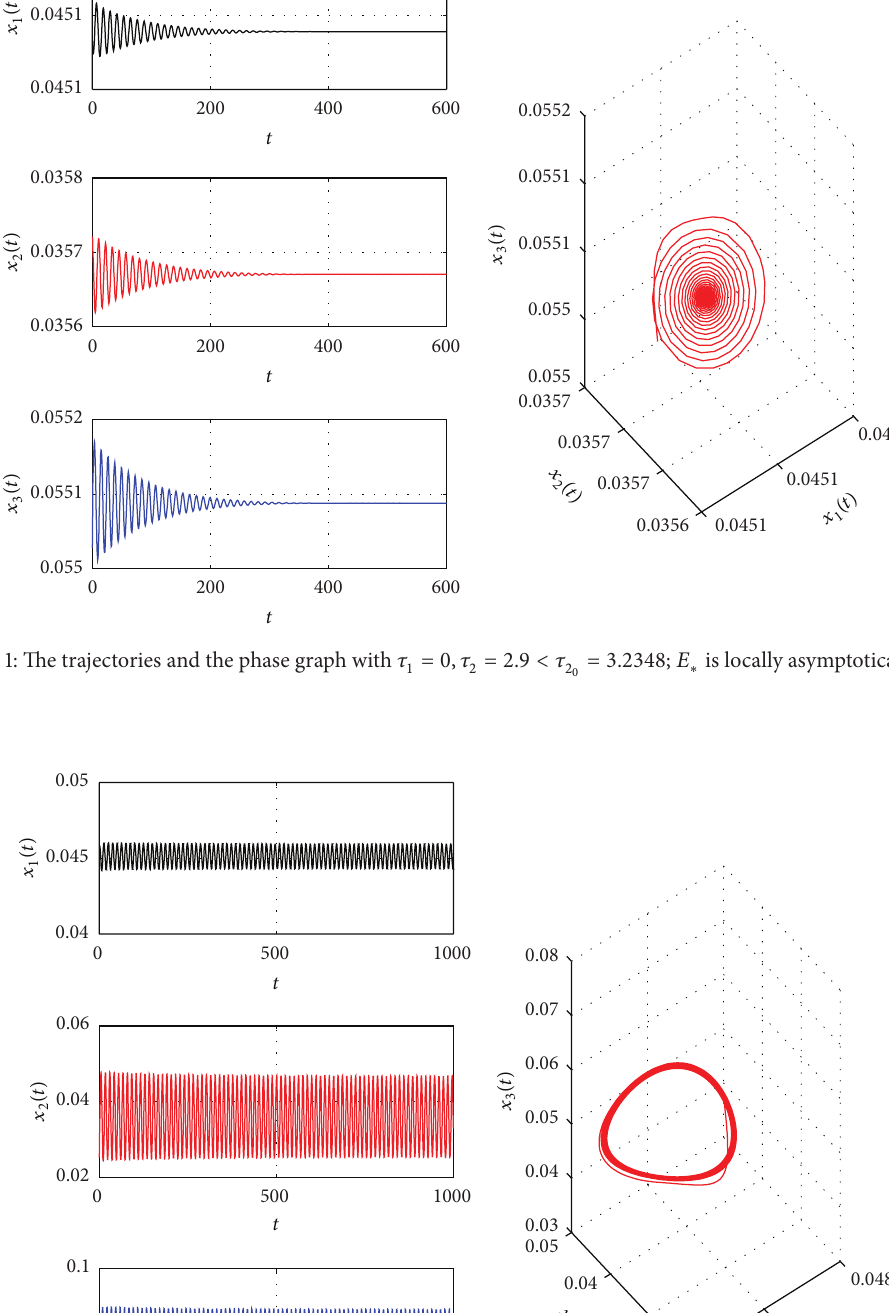
Figure 2: The trajectories and the phase graph with 𝜏 1 = 0, 𝜏 2 = 3.3 > 𝜏 2